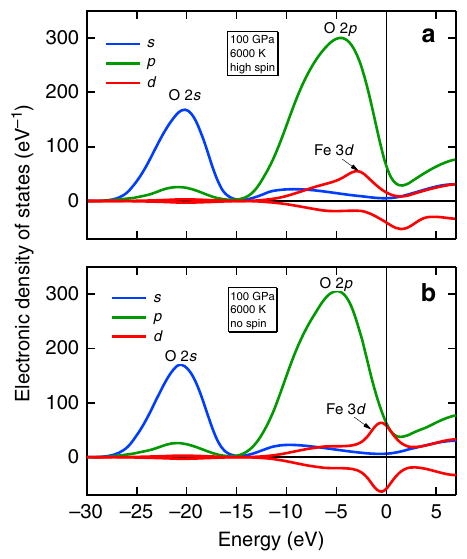
Fig. 2 Electronic density of states in the silicate liquid. At 100 GPa and 6000 K in spin-polarized ( a ) and non-spin-polarized ( b ) states. Contributions from s - (blue), p - (green) and d -like (red) states are shown separately and the dominant atomic contributions to each are indicated. The vertical black line is the Fermi